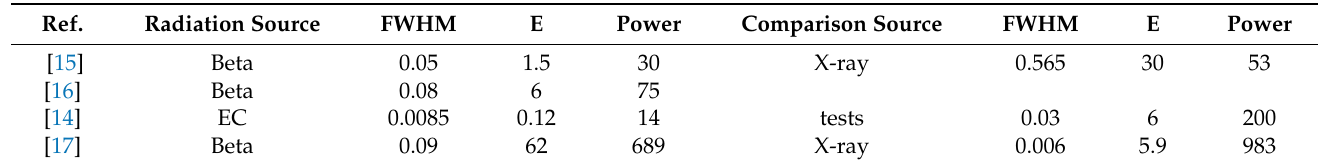
Table 2. Energy resolution values for four papers. The resolving power is determined by dividing the energy by the FWHM. All energies are in units of keV.